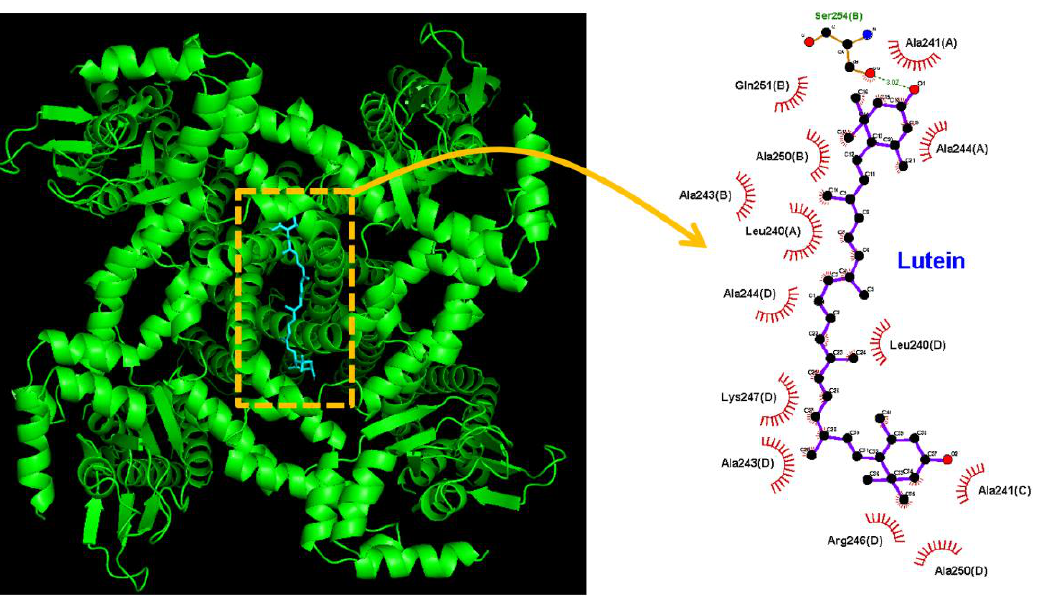
Figure 8. Docking results of HCN channel and the lutein molecule. The protein structure of HCN channel was acquired from RCSB PDB (PDB ID: 5V4S), while the lutein structure was from PubChem (Compound CID: 5281243). The structure of the HCN channel was docked with the lutein molecule through PyRx software (https://pyrx.sourceforge.io/) (accessed on 1 June 2022). The diagram of the interaction between the HCN channel and the lutein molecule was generated by LigPlot + (https://www.ebi.ac.uk/thornton-srv/software/LIGPLOT/) (accessed on 1 June 2022). Of note, the red arcs with spokes radiating toward the ligand (i.e., lutein) indicate hydrophobic contacts, whereas the green dot line depicts hydrogen bond.